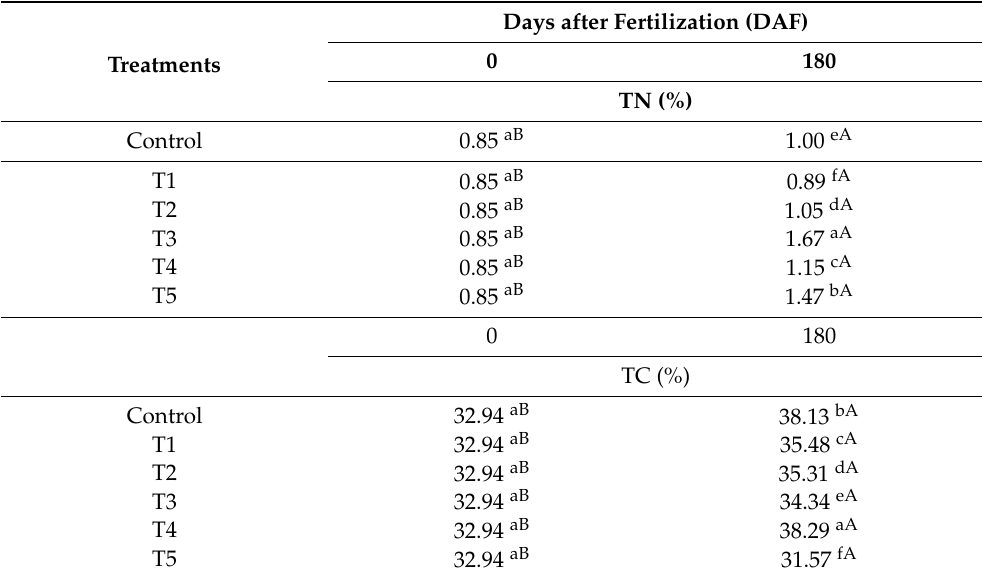
Table 4. Total nitrogen (TN), total carbon (TC) of substrate samples of cocoplum plants grown in different fertilization rate at 0 and 180 days after